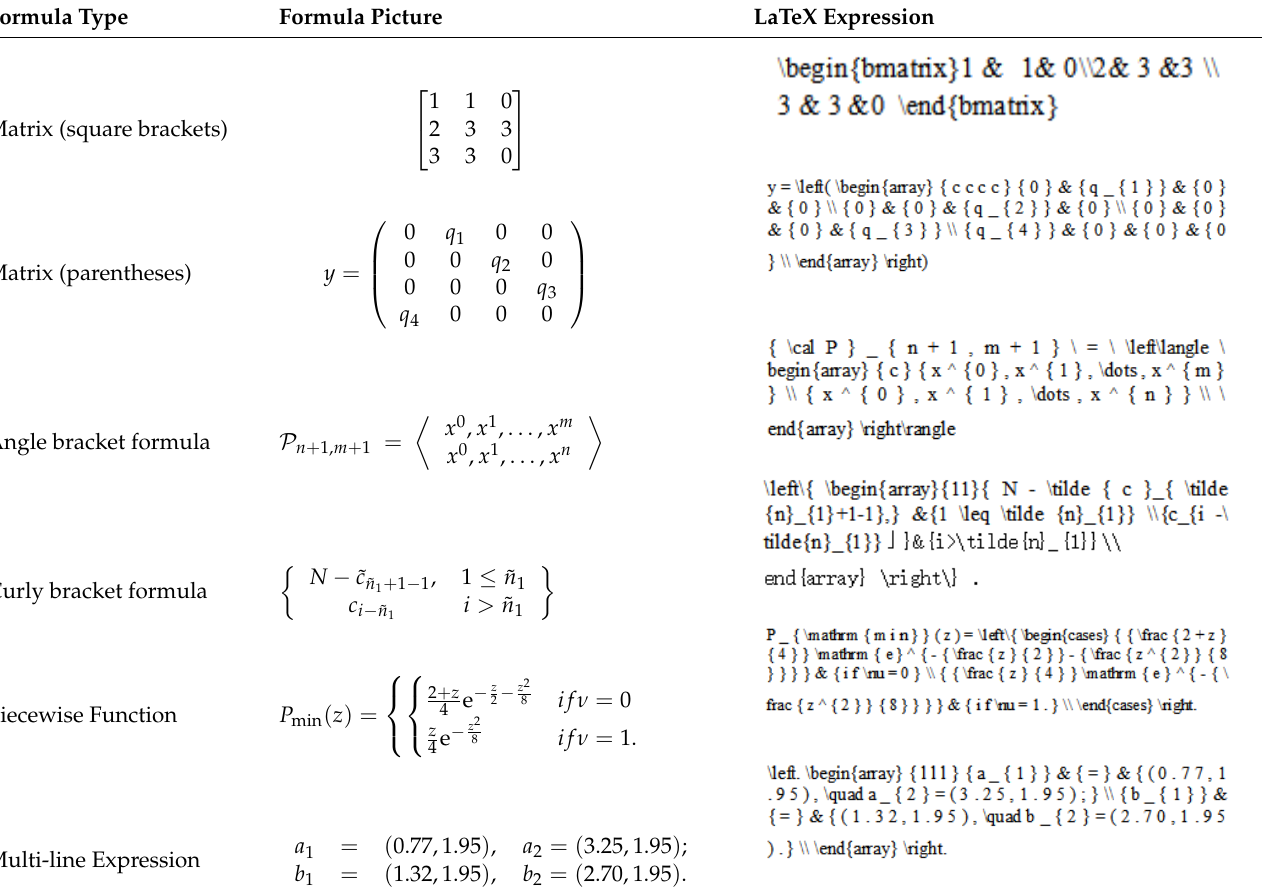
Table 1. Multi-line formula